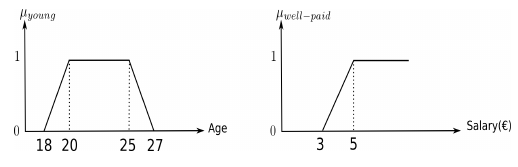
Fig. 2. Predicates (a) young (b) well-paid A typical example of a fuzzy query is: “re- trieve the employees which are young and well- paid ”, where young and well-paid are gradual pred- icates represented by means of fuzzy sets as illus- trated in Figure